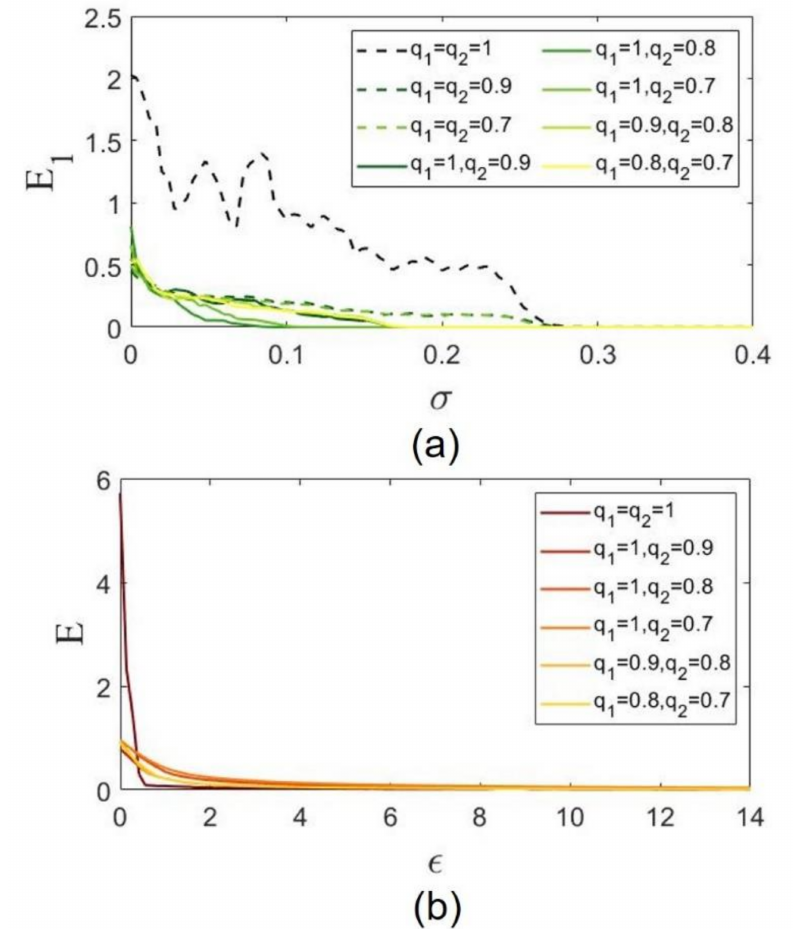
Figure 5. ( a ) The intralayer synchronization error ( E 1 ) according to the intralayer coupling strength ( σ ) for (cid:101) = 1. ( b ) The interlayer synchronization error ( E ) according to the interlayer coupling strength ( (cid:101) ) for σ =